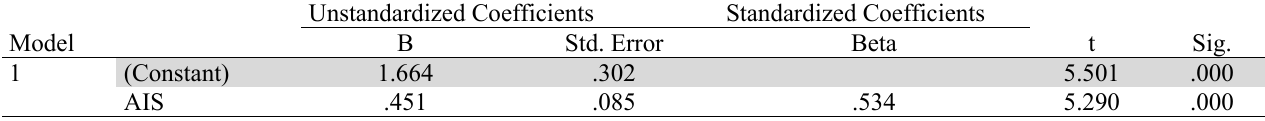
The summary of regression analysis on the effect of AIS on controlling corporate governance